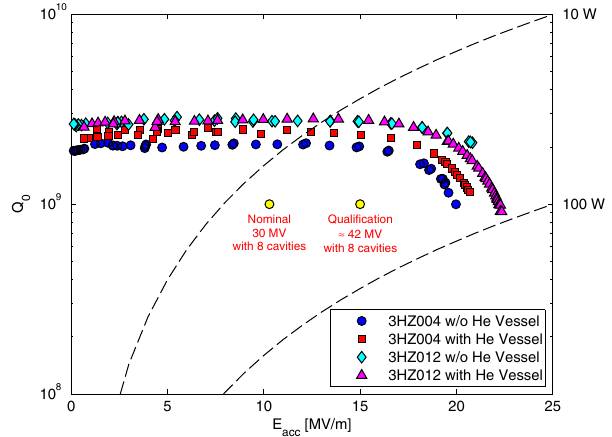
FIG. 15. Power rise comparison for cavity 3HZ004 and 3HZ012 before and after the He vessel